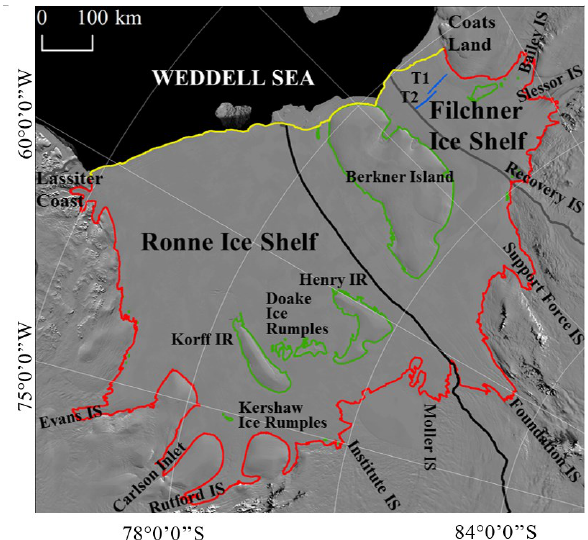
Figure 1. Study area of the Filchner-Ronne Ice Shelf in Antarctica: the ice shelf boundary is represented by grounding line (red lines) and ice rises (green lines) adopted from Depoorter et al. (Depoorter et al., 2013), and the ice shelf front (yellow line) is taken from MOA coastline data (2008-2009) (Haran et al., 2014); Rift T1 and Rift T2 (blue lines) in the Filchner Ice Shelf; and a background image from the MOA mosaic of 2008 - 2009 (Haran et al.,